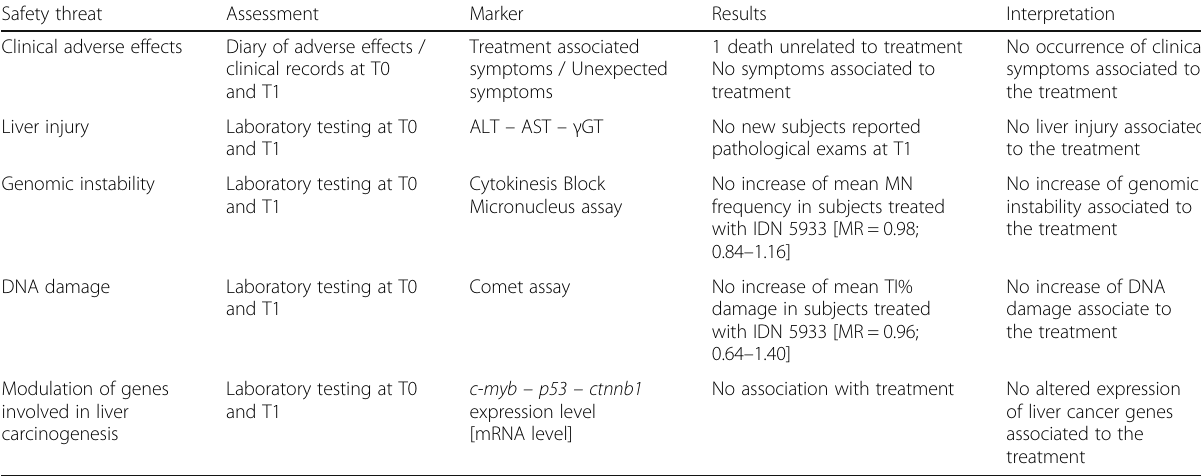
Table 5 Synthesis of main results concerning the assessment of clinical and genomic safety of subjects treated with IDN 5933 Safety